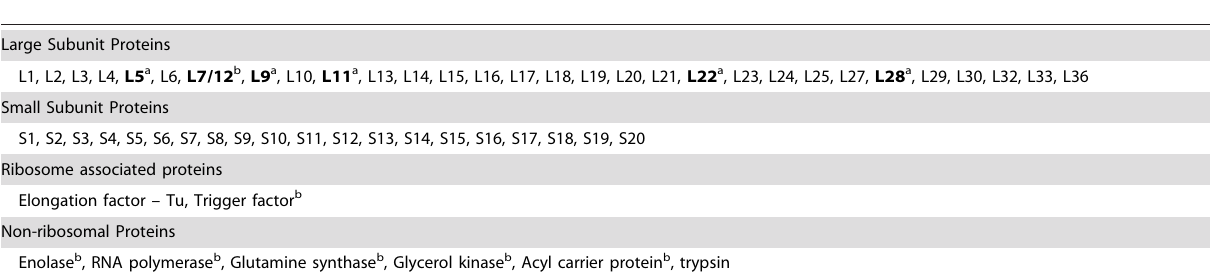
Table 1. Comparative iTRAQ analysis of M. smegmatis ribosomal fractions by mass spectrometry.